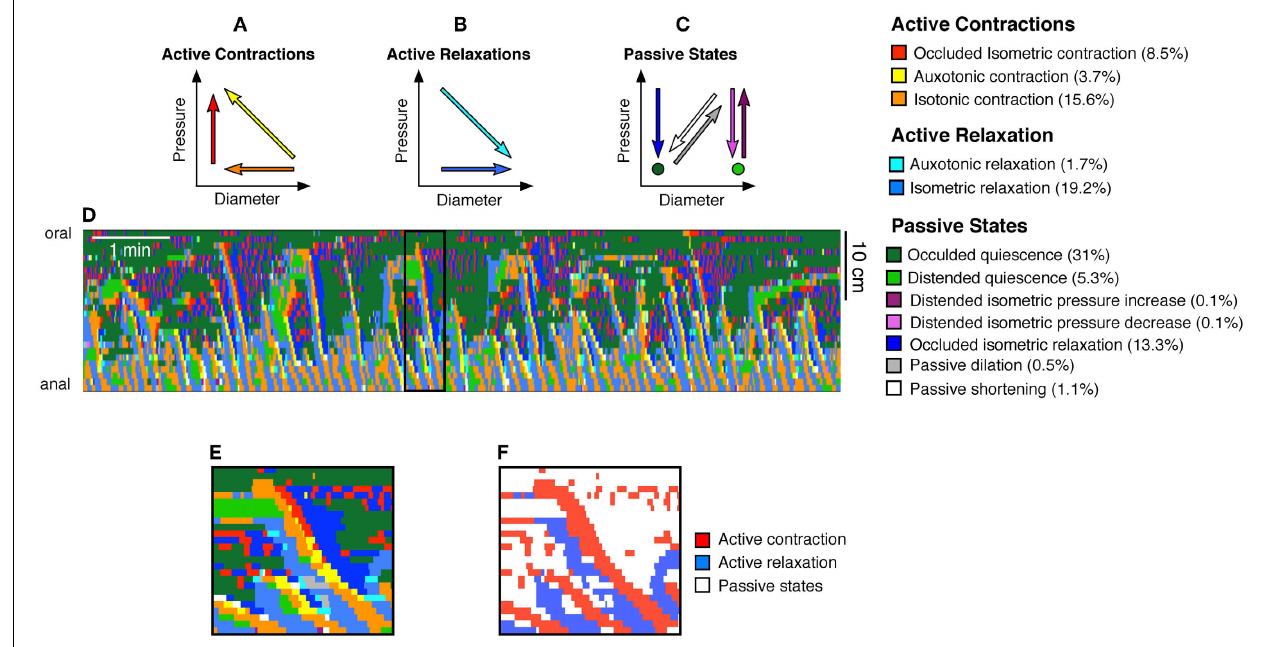
FIGURE 3 | From the orbital plots, 12 mechanical states were identified as described before (Costa et al., 2013b). These mechanical states were divided into (A) active contractions, (B) active relaxations, and (C) passive states. The color coded arrows shown in (A–C) indicate the trajectories of pressure and diameter which define each state. For example, the red arrow in (A) indicates an increase in pressure with no change in diameter, and this mechanical state represents an occluded isometric contraction. Taking the same DPMap shown in Figure 2A we can then determine the location and